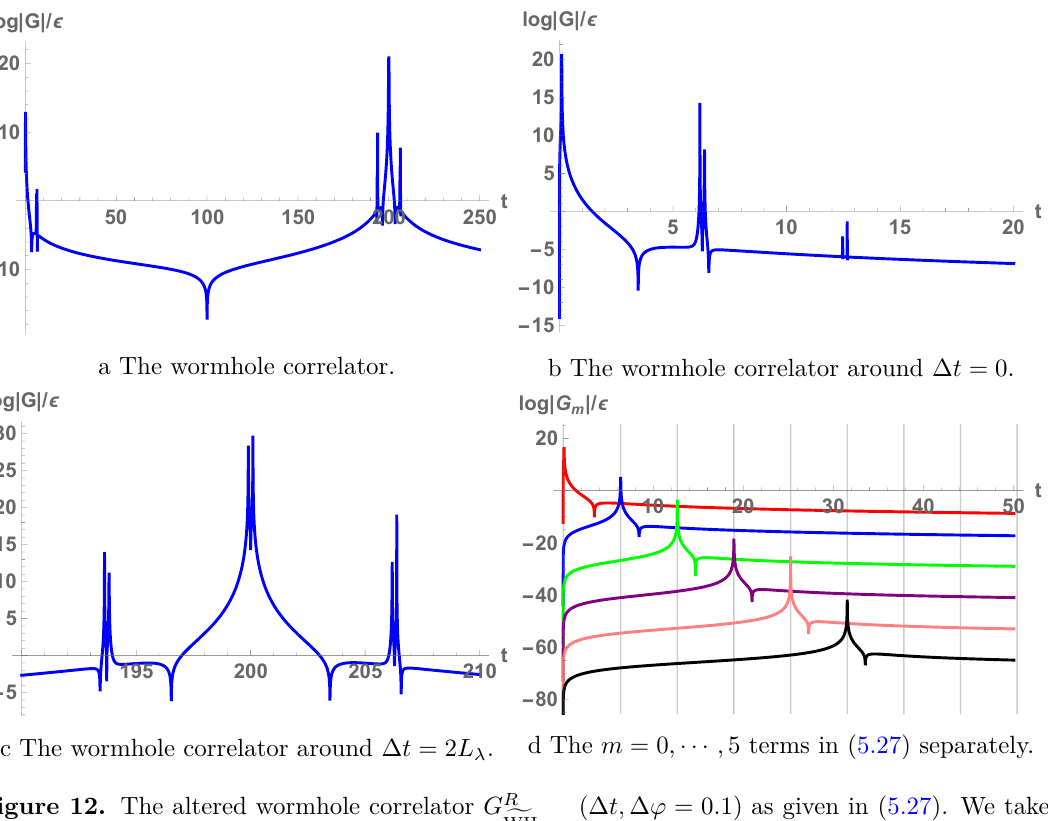
Figure 12. The altered wormhole correlator G R R = r + = 1 , (cid:15) = 10 − 10 , and L λ = 100 . We see the clear onset of the first echo at ∆ t = 2 L λ